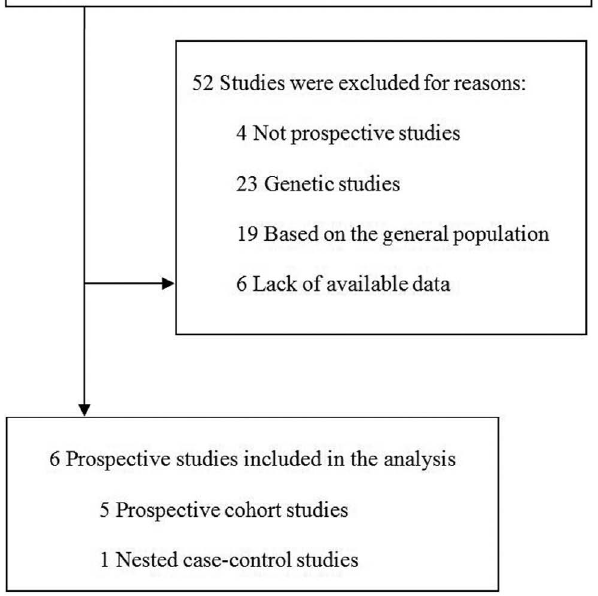
Figure 1. Selection of studies for systematic review of association between adiponectin concentrations and risk of cardiovascular diseases in diabetic patients.